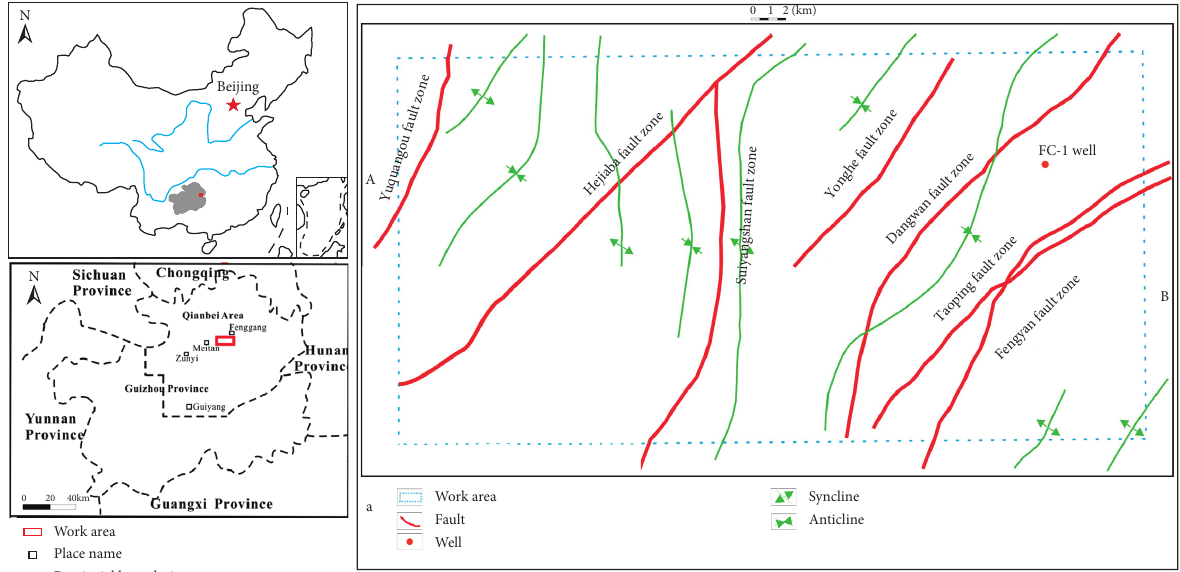
Figure 1: Regional map of the no. 3 block of Fenggang, northern Guizhou [28].